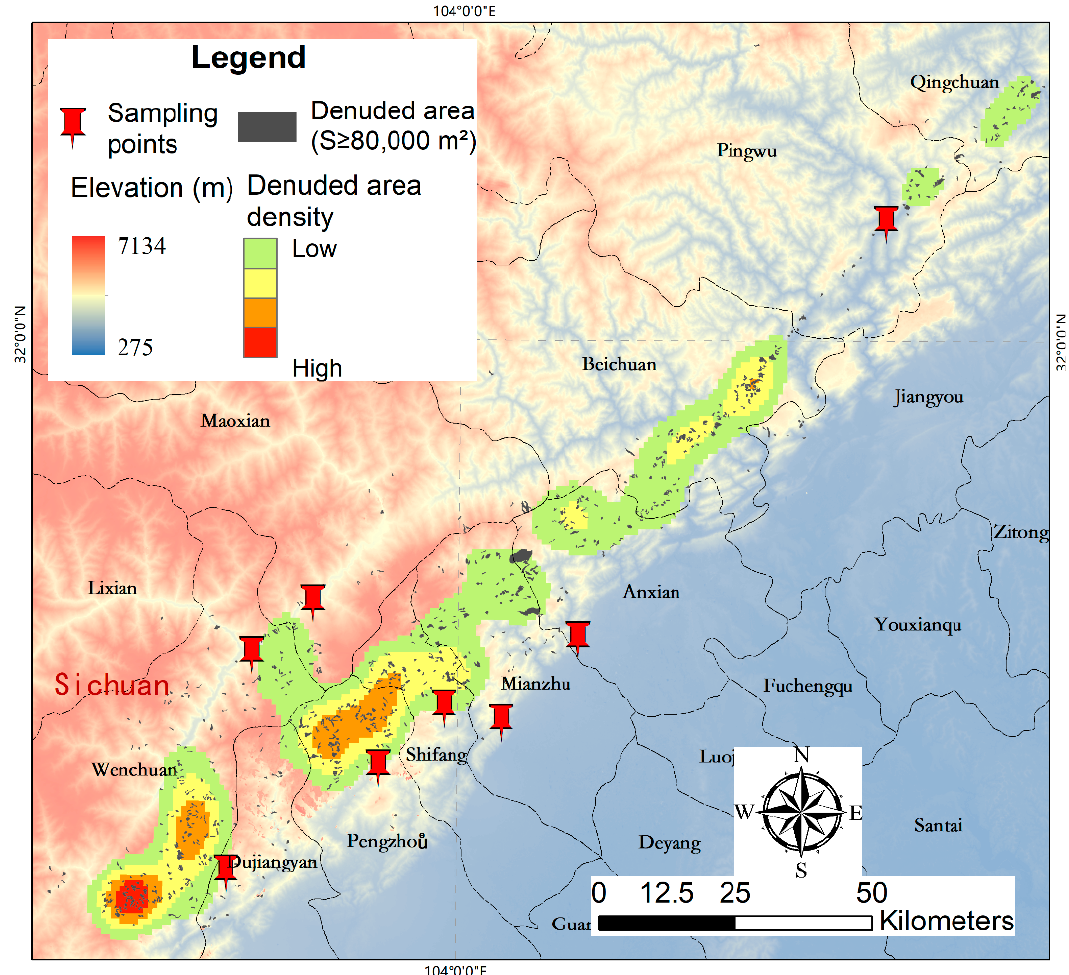
Figure 9. Denuded areas (S ≥ 80,000 m 2 ) and sampling locations.